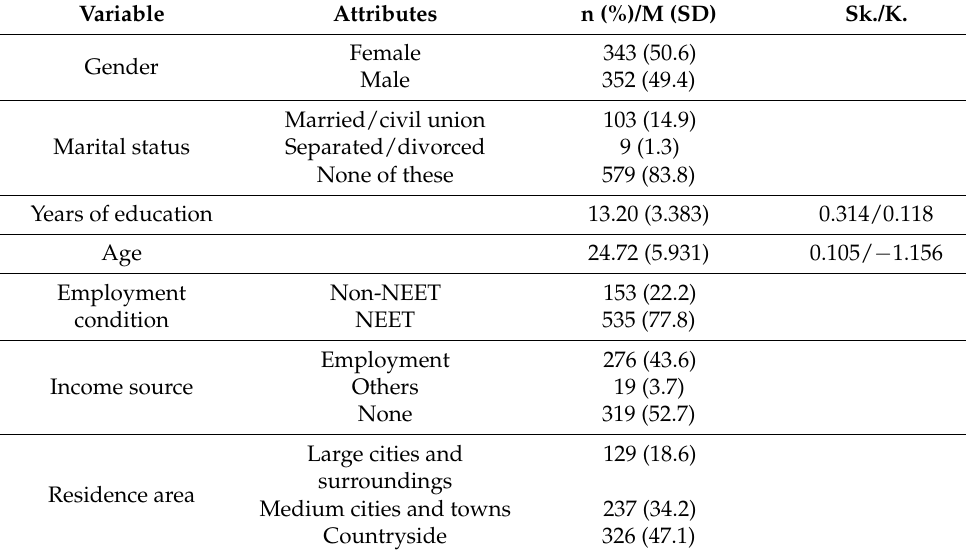
Table 1. Sociodemographic characteristics of the sample (N =